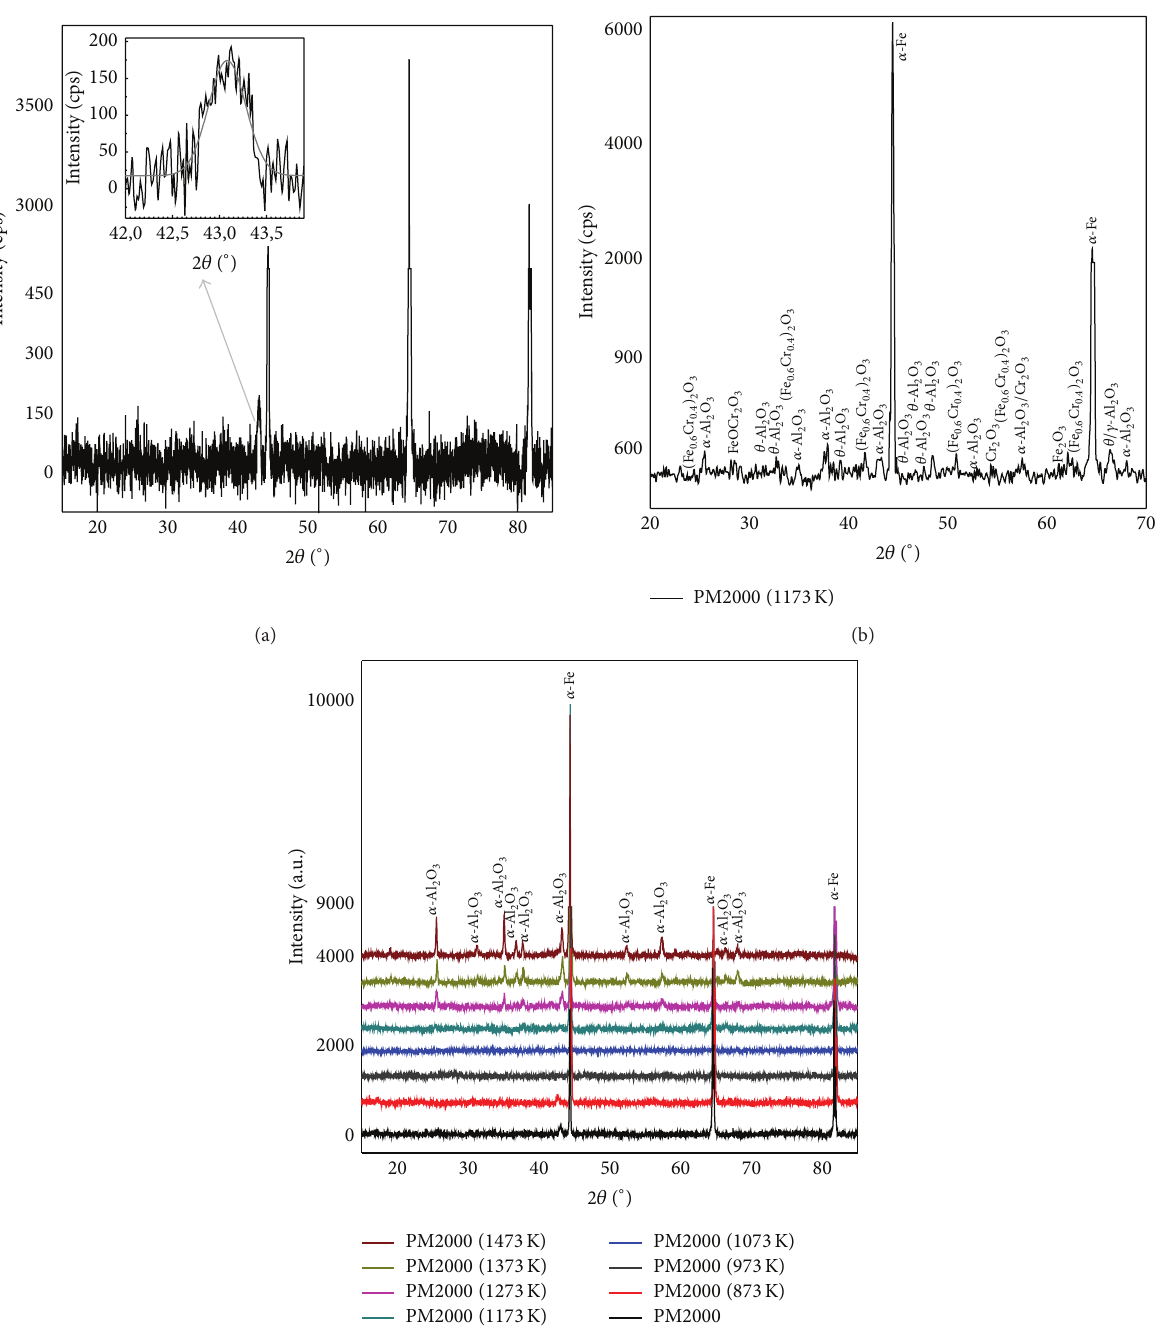
Figure 4: XRD powder patterns of as-received PM2000 (a), heat treated on air at 1173K (b), and heat treated on air from 873 to 1473 K (c).